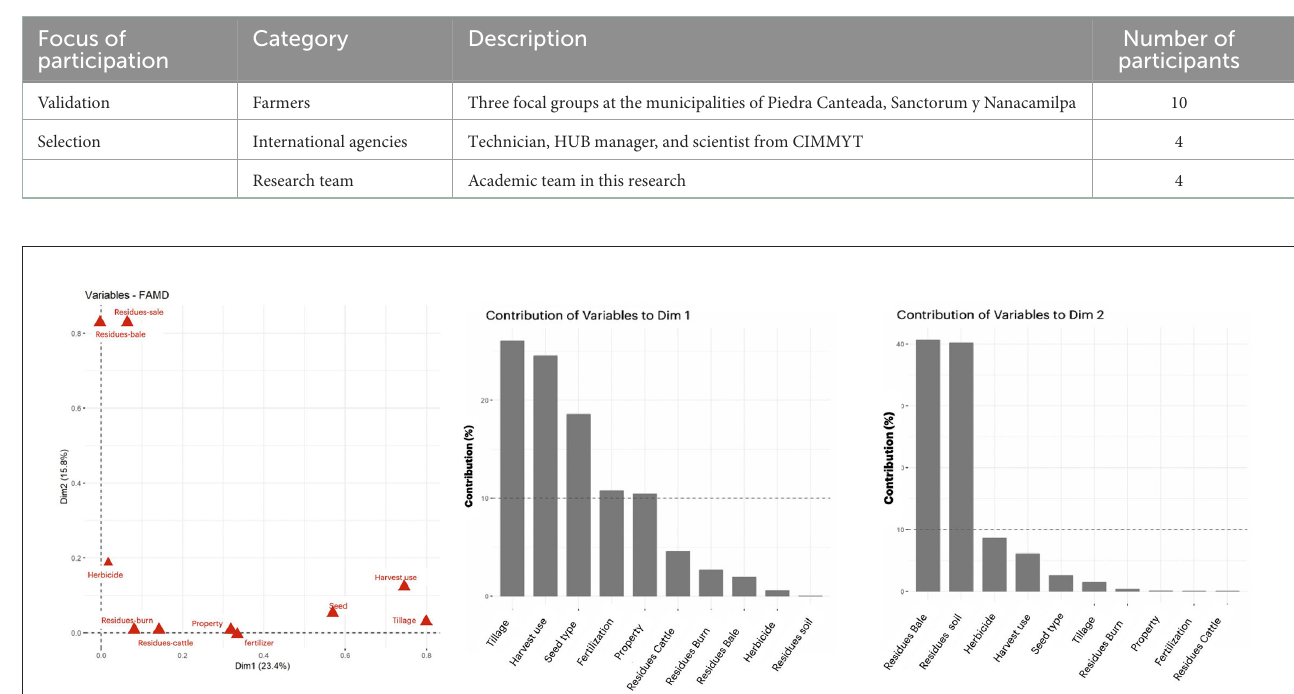
FIGURE3 The graph on the (Left) shows the coordinates from the variables that construct the FAMD. The main variables in DM1 (23.5%) are tillage, harvest use, and seed type. In DM2 (15.9%), the main variables are the use of crop residues for sale or use as bale. The weight (%) of variables in each FAMD component is shown in the (Central) graph for DM1 and on the (Right) for DM2.